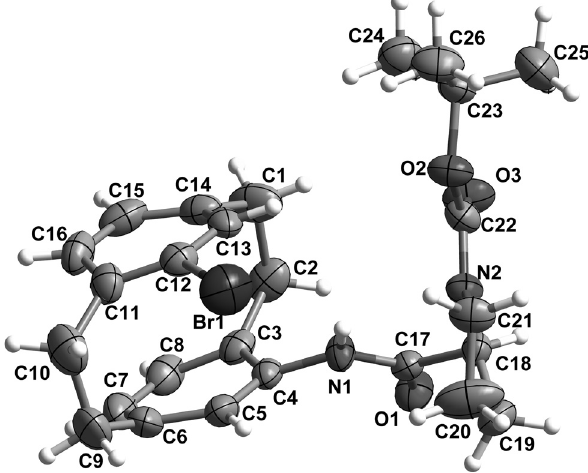
Table  : Data collection and